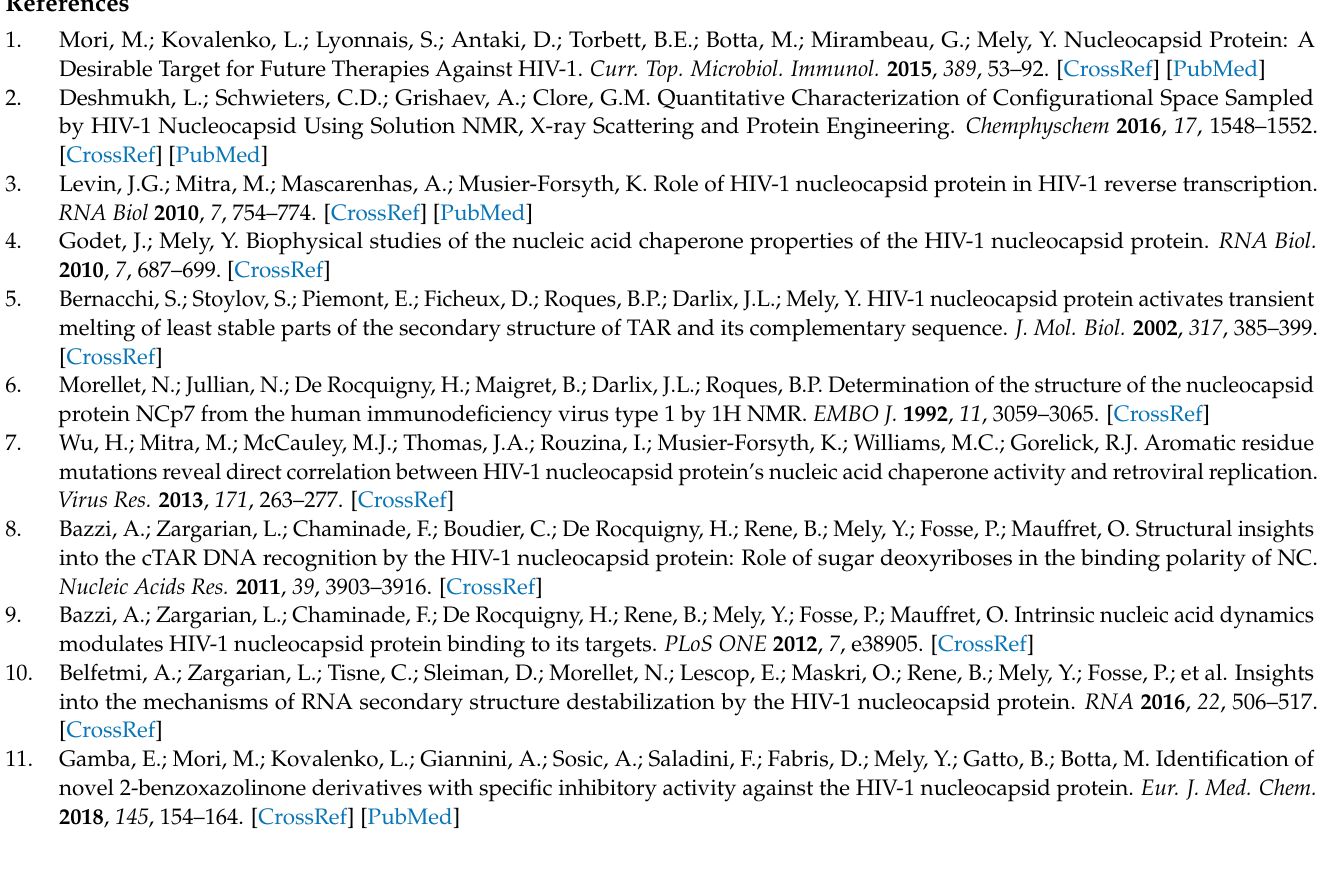
Figure S1: Dose–response curves resulting from the NC-mediated melting in the presence of 2,6-AQs on TAR substrate. Table S1: Inhibition of NC-mediated melting of cTAR by AQ-AA 1 - L -Tyr (red columns) and AQ-AA 1 - D -Tyr (green columns). Figure S2: Representative ESI-MS spectra of samples obtained by mixing TAR with compounds of the L -Tyr and D -Tyr series. Table S2: Binding stoichiome- tries of compound-nucleic acid complexes detected in the ESI-MS spectra. Table S3: Variations of TAR, cTAR, and TAR/cTAR hybrid melting temperature ( ∆ Tm) in the presence of an increasing concentration of the compounds of the L -Tyr and D -Tyr series. Figure S3: Representative ESI-MS spectra of samples obtained by mixing NC with compounds of the L -Tyr and D -Tyr series. Figure S4: Representative ESI-MS spectra of samples obtained by mixing Tat with compounds of the L -Tyr and D -Tyr series. Table S4: Experimental and calculated monoisotopic masses (Da) of 2,6-AQ:Tat com- plexes. Figure S5: ESI-MS spectra of samples obtained by adding NC to the preformed ligand • TAR complexes. Figure S6: Parallel Artificial Membrane Permeation Assays